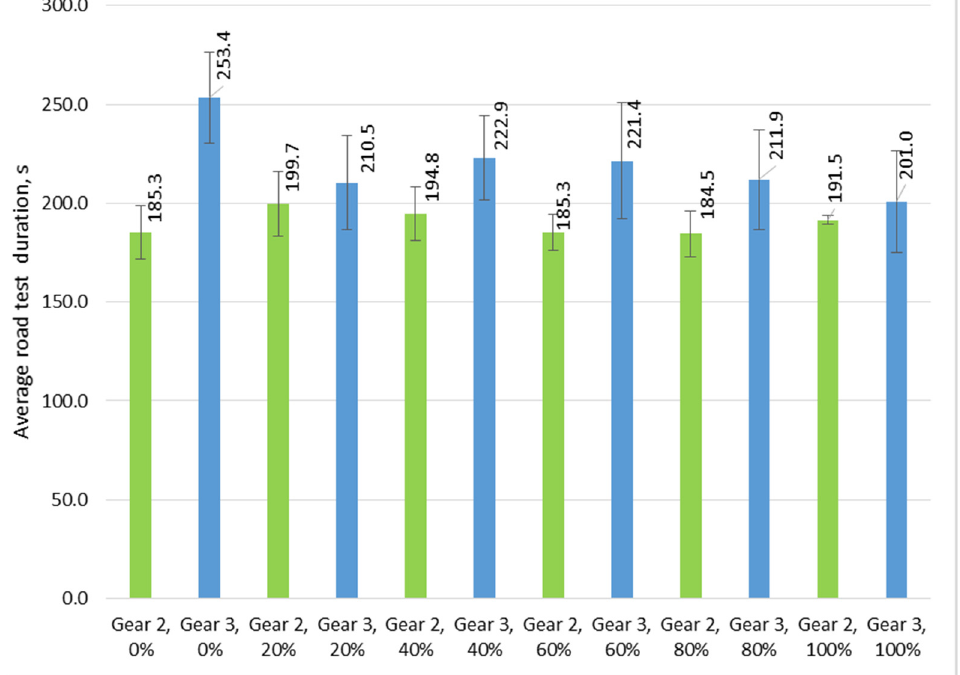
Figure 5. Average duration of road test replications at different regenerative braking settings.